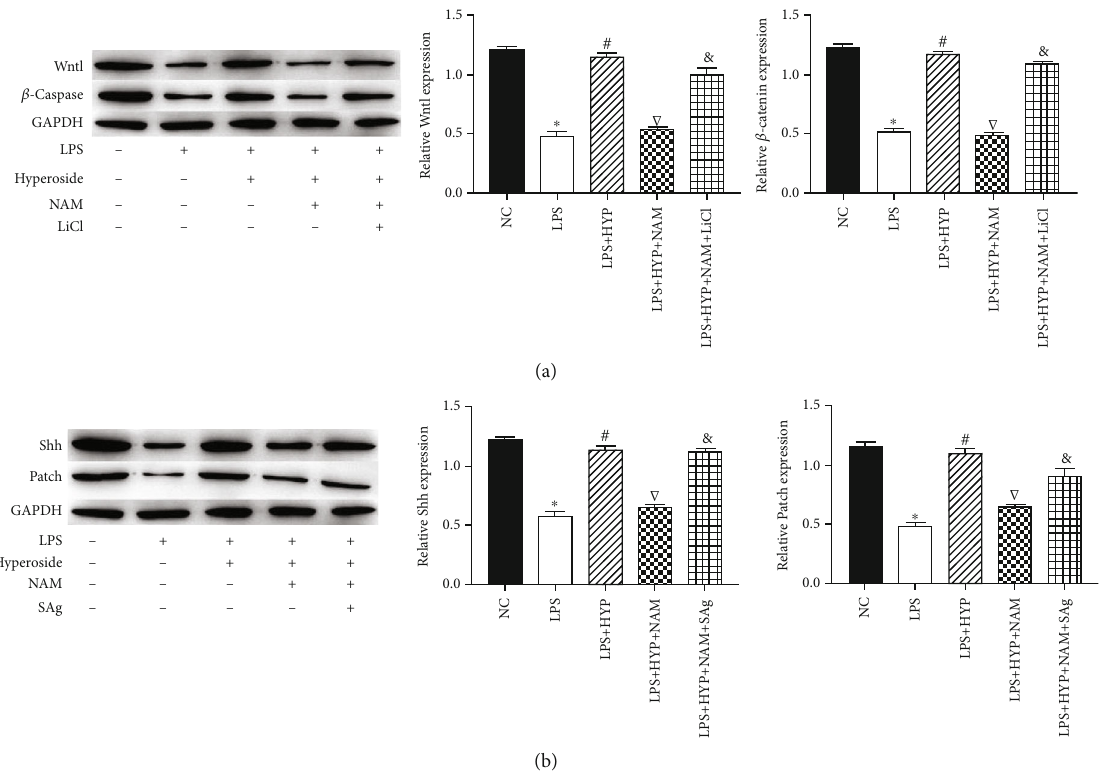
Figure 5: Hyperoside activates Wnt/ β -catenin and sonic hedgehog pathways by upregulating SIRT1. The expression of Wnt1 and β -catenin in HT22 cells was measured by western blotting (a). The expression of Shh and patch in HT22 cells was measured by western blotting (b). ∗ was considered signi fi cant compared to control ( ∗ P < 0 : 05 ); # was considered signi fi cant compared to LPS ( # P < 0 : 05 ); ▽ was considered signi fi cant compared to LPS+HYP ( ▽ P < 0 : 05 ); & was considered signi fi cant compared to LPS+HYP+LiCl or LPS+HYP+SAg ( & P < 0 : 05